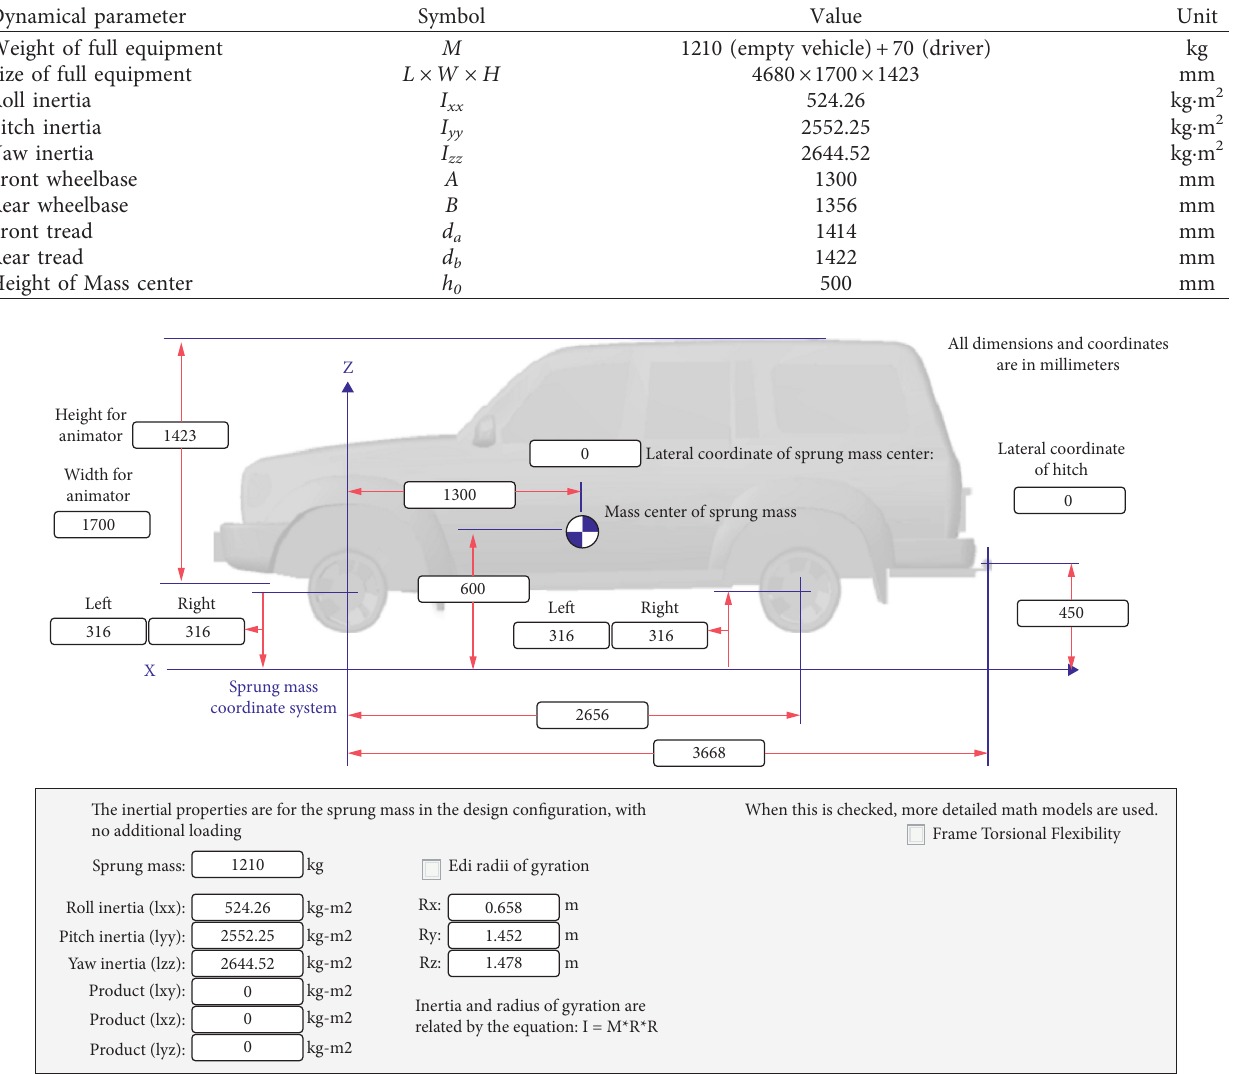
Figure 4: Parameter settings in